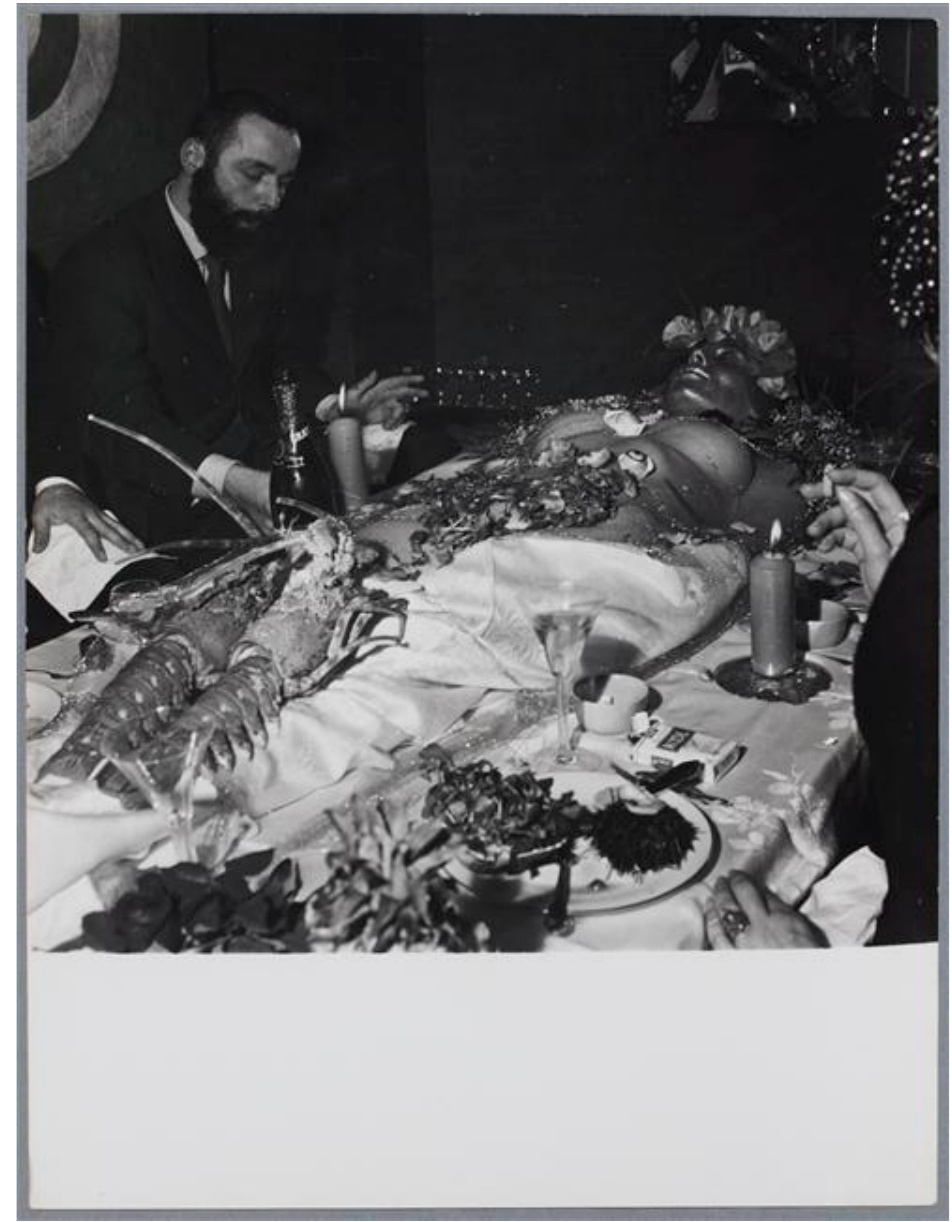
Figure 1. EROS à la Galerie Daniel Cordier (1959–1960). Meret Oppenheim, Cannibal Banquet (Feast), 1959. Photo: Van Hecke Roger, Photo (C) Centre Pompidou, MNAM-CCI Bibliothèque 1959. Photo: Van Hecke Roger, Photo (C) Centre Pompidou, MNAM-CCI Biblioth è que Kandinsky, Kandinsky, Dist. RMN-Grand Palais/Fonds Breton © 2022, ProLitteris, Zurich. Dist. RMN-Grand Palais/Fonds Breton © 2022, ProLitteris,